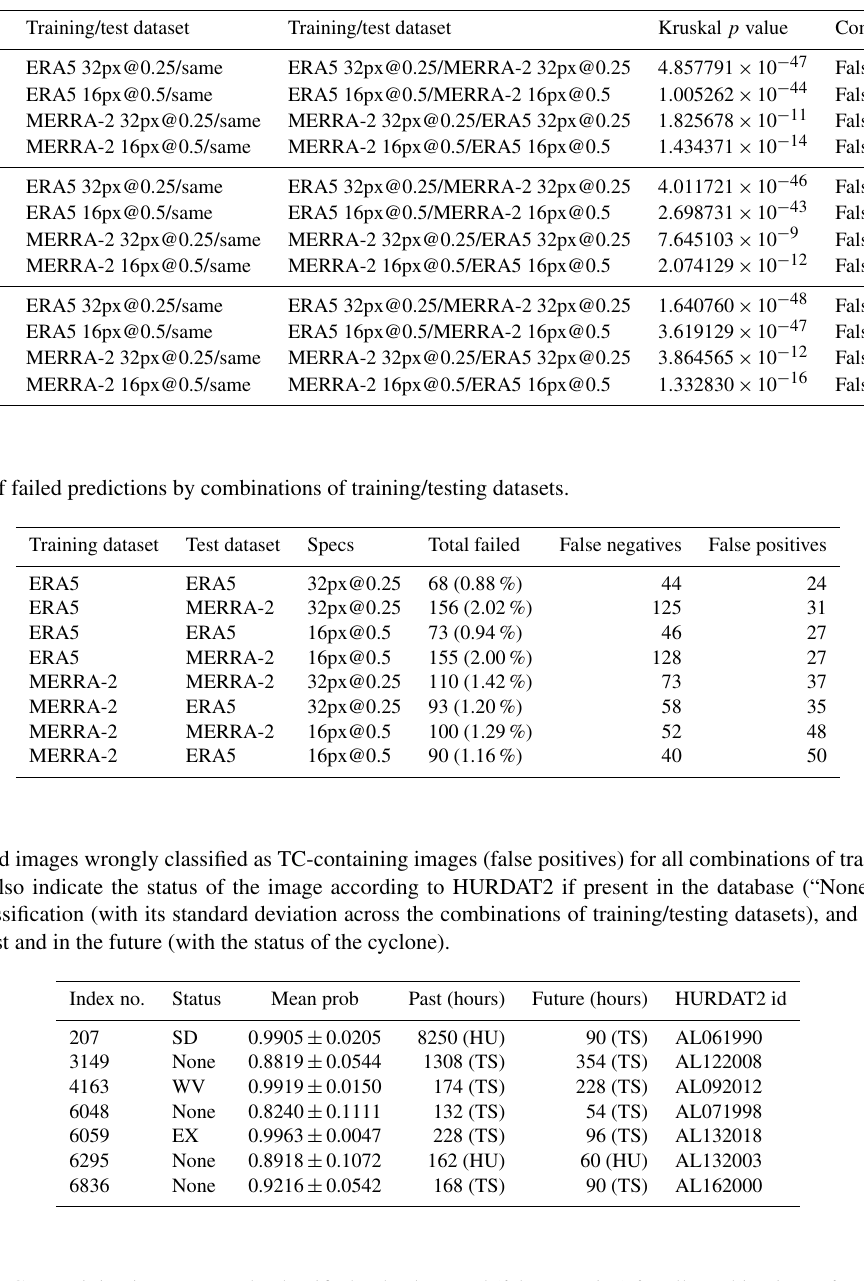
Table A8. The single TC-containing image wrongly classified as background (false negative) for all combinations of training/testing datasets. The status of the image according to HURDAT2 and the probability of the classification (with its standard deviation across the combinations of training/testing datasets) are indicated. The columns past and future reflect the cyclonic activity in the geographical area of the image, i.e., the temporal distance to the first and the last tracks of the cyclone (and their HURDAT2 status). Index